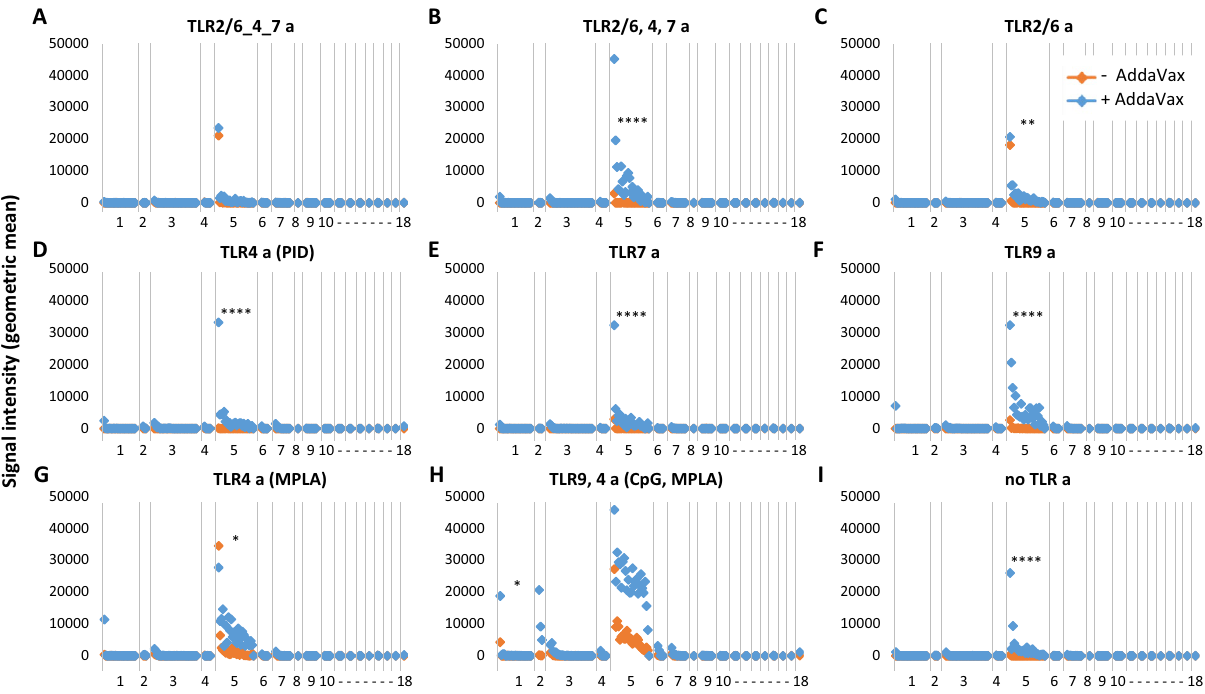
Figure 2. IgG profiles in response to trimerized influenza virus VN04 H5 vaccine formulated with different TLR agonists, with or without squalene oil-in-water emulsion (AddaVax). As per Fig. 1, except arrayed antigens (horizontal axis) are HA1 regions of HA. Abbreviations, as Fig.